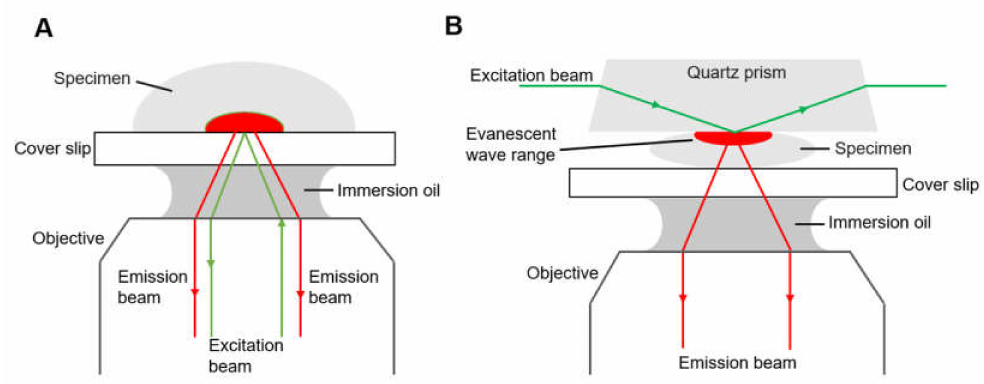
Figure 3. Diagrams of two types of total internal reflection fluorescence microscope, ( A ) objective-type TIRFM and ( B ) prism-based